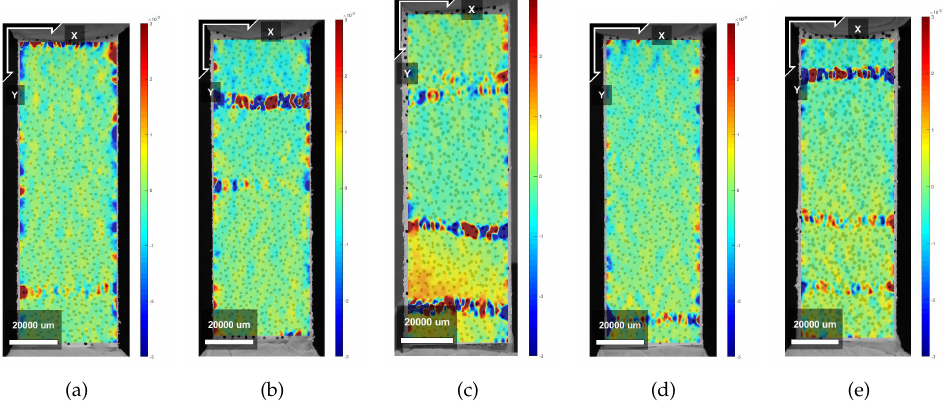
Figure 10. Crack pattern obtained from DIC analysis on Y samples—Horizontal